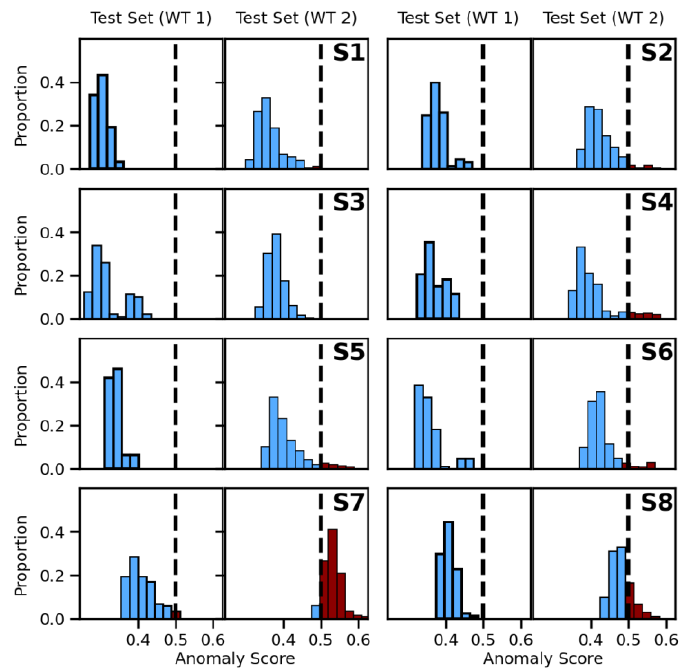
Figure 8. Fault detection based on isolation forest models. Visualization of the isolation forest anomaly scores for accelerometers S1–S8. In all cases, the vibration responses from WT1 were correctly classified as healthy based on their low anomaly score. Significantly larger anomaly scores were obtained for accelerometers S7 and S8 of WT2. This indicates a fault in the generator, which is consistent with the results of our reconstruction-error-based fault detection method (Figures 6 and 7).